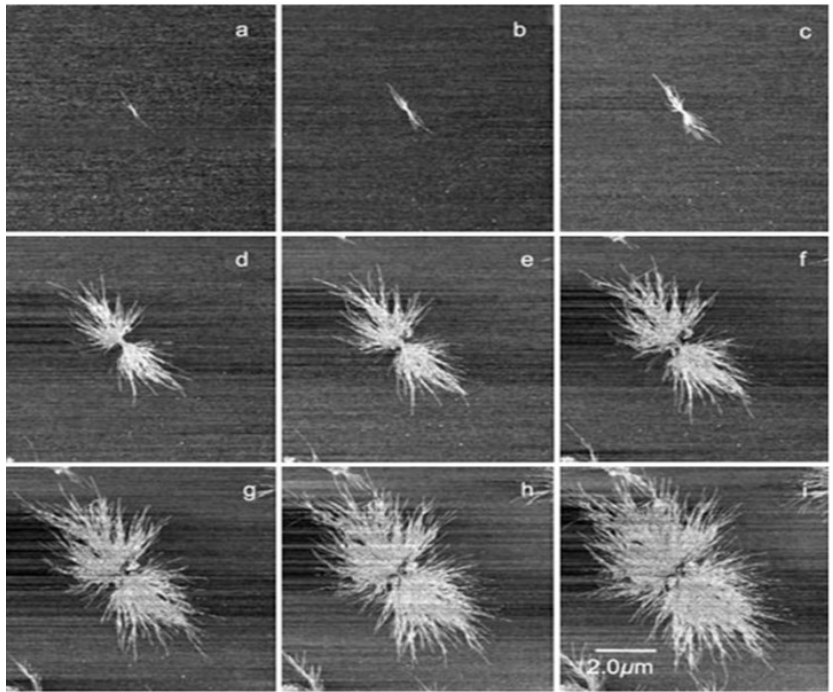
Figure 6. Phase images of spherulite development in PBA-C8 at different crystallization times: ( a – i ) The temperature was 30 °C and the overall time was 167 min. Reproduction with permission of Elsevier [128,132].